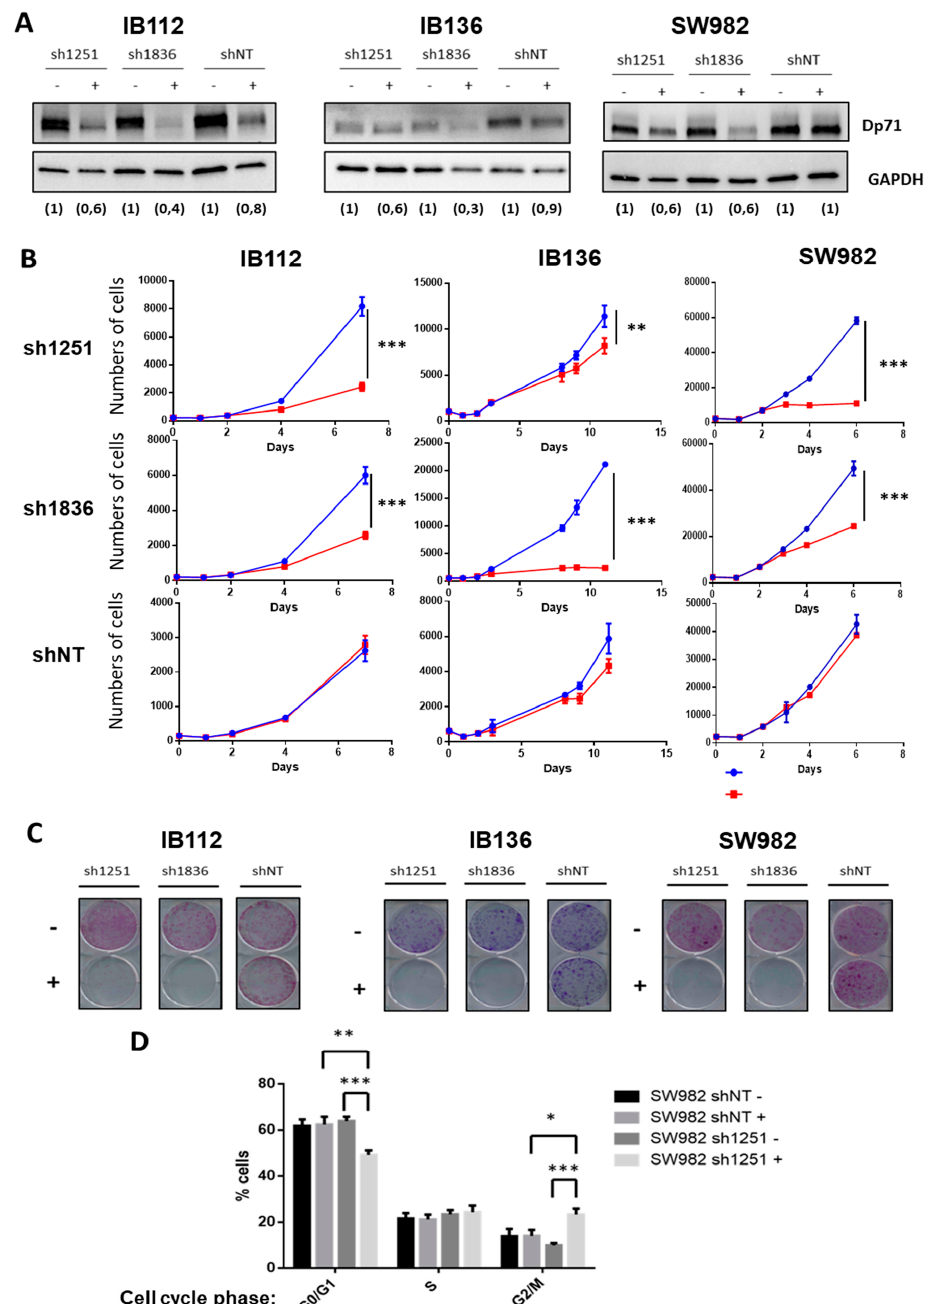
Figure 4. Dp71 inhibition reduced cell proliferation and clonogenicity . ( A ) Effective Dp71